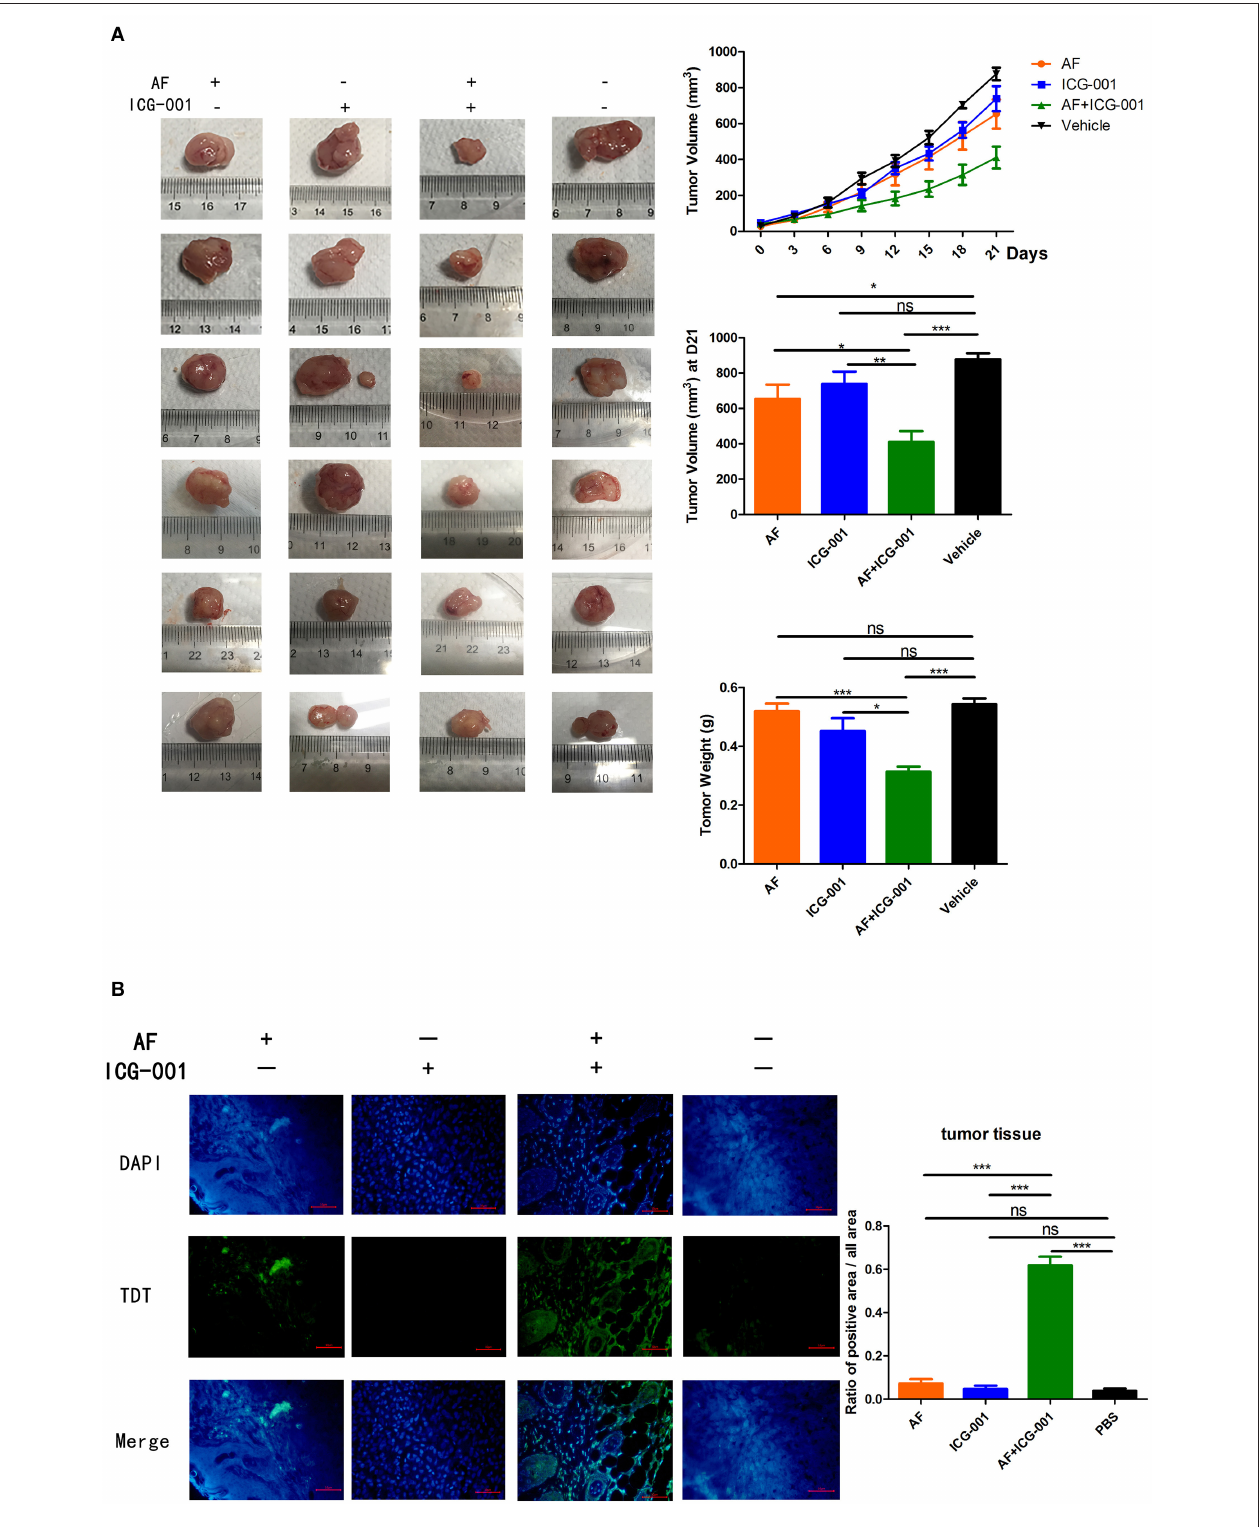
FIGURE 7 | Combination of AF and ICG-001 suppresses CBC growth in vivo . CIPp cells were injected subcutaneously into the left mammary fat pad of 5-week-old female null-balb/c mice, n = 6. (A) The tumor volume during treatment and the tumor weight by the end of the treatment. (B) TUNEL results of the tumor tissues at the end of the treatment. Data were representative of three independent experiments. p -values: * p < 0.05; ** p < 0.01; *** p < 0.001; ns, non-significant.